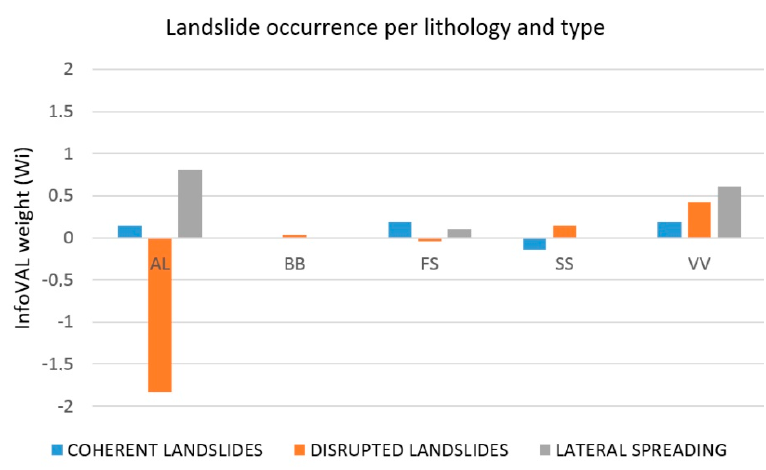
Figure 7. Statistical correlation between landslide occurrence and lithology type; correlation is expressed as an InfoVAL weight (Wi), where positive values indicate a statistically significant correlation (see methods for further details); lithology codes are the same as in Figure 6.